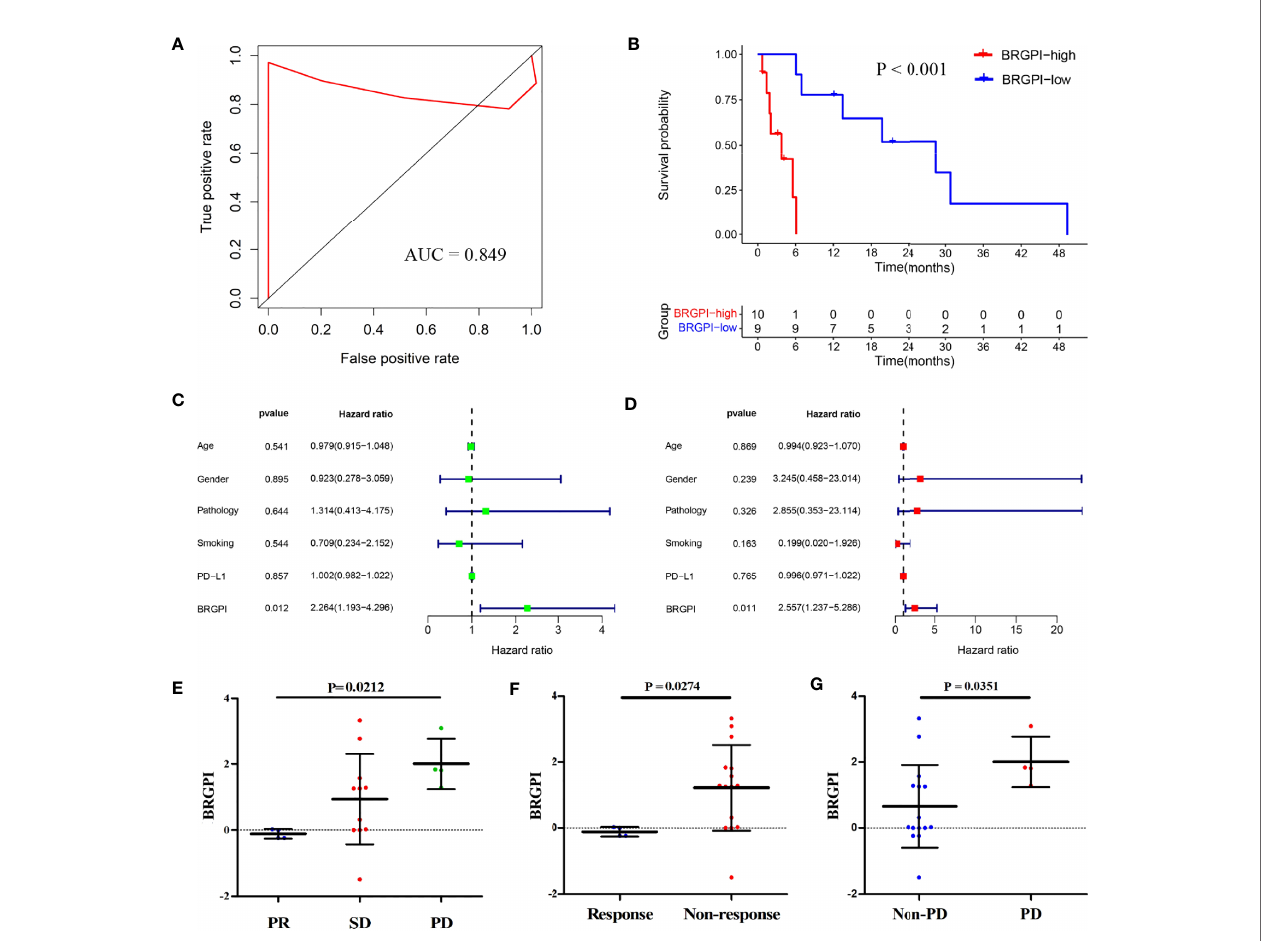
FIGURE 3 | Independent validation of the BRGPI for patients with NSCLC treated with anti-PD-1 immunotherapy in the CICAMS cohort. (A) ROC analysis of the BRGPI for progression-free survival. (B) Survival curve of progression-free survival for patients with NSCLC treated with anti-PD-1 immunotherapy according to the BRGPI. (C, D) Univariate (C) and multivariate (D) regression analyses of the associations between BRGPI and clinical variables for the predictive ability of progression-free survival. (E) The distributions of the BRGPI scores among the patients receiving PR, SD, and PD. (F) The distributions of the BRGPI scores between the two groups (response and non-response). (G) The distributions of the BRGPI scores between the two groups (Non-PD and